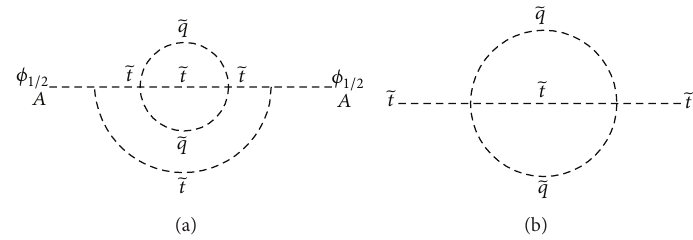
Figure 15: (a) Feynman diagram involving a heavy virtual squark contributing to the Higgs boson self-energy. (b) Counterterm diagram related to the diagram in (a). The same notation as in Figure 13 has been adopted.